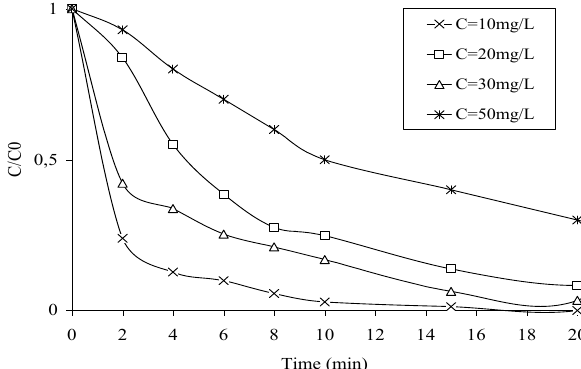
]= 30mg/L, catalyst mass=0.005g) i